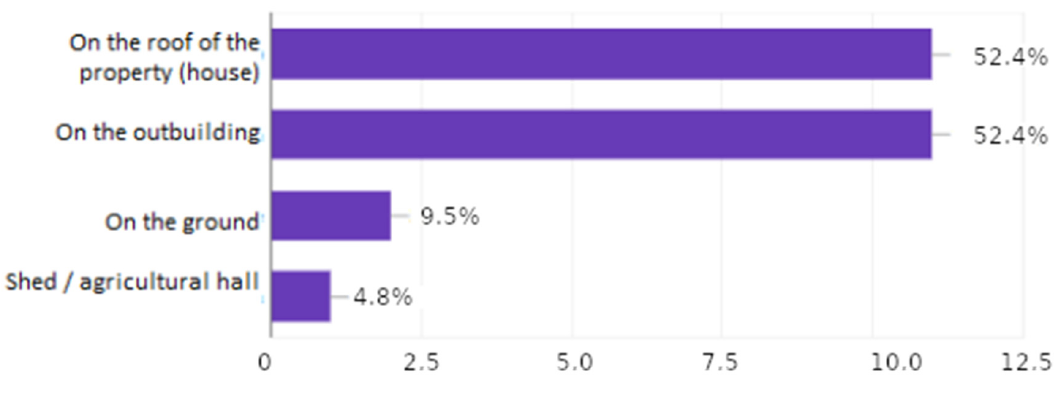
Figure 12. Place of installation of photovoltaic panels.